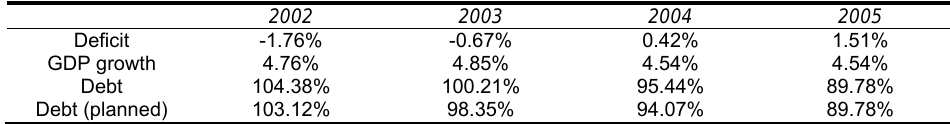
Table 10. Italian government deficit plan after a one-time deviation and revision